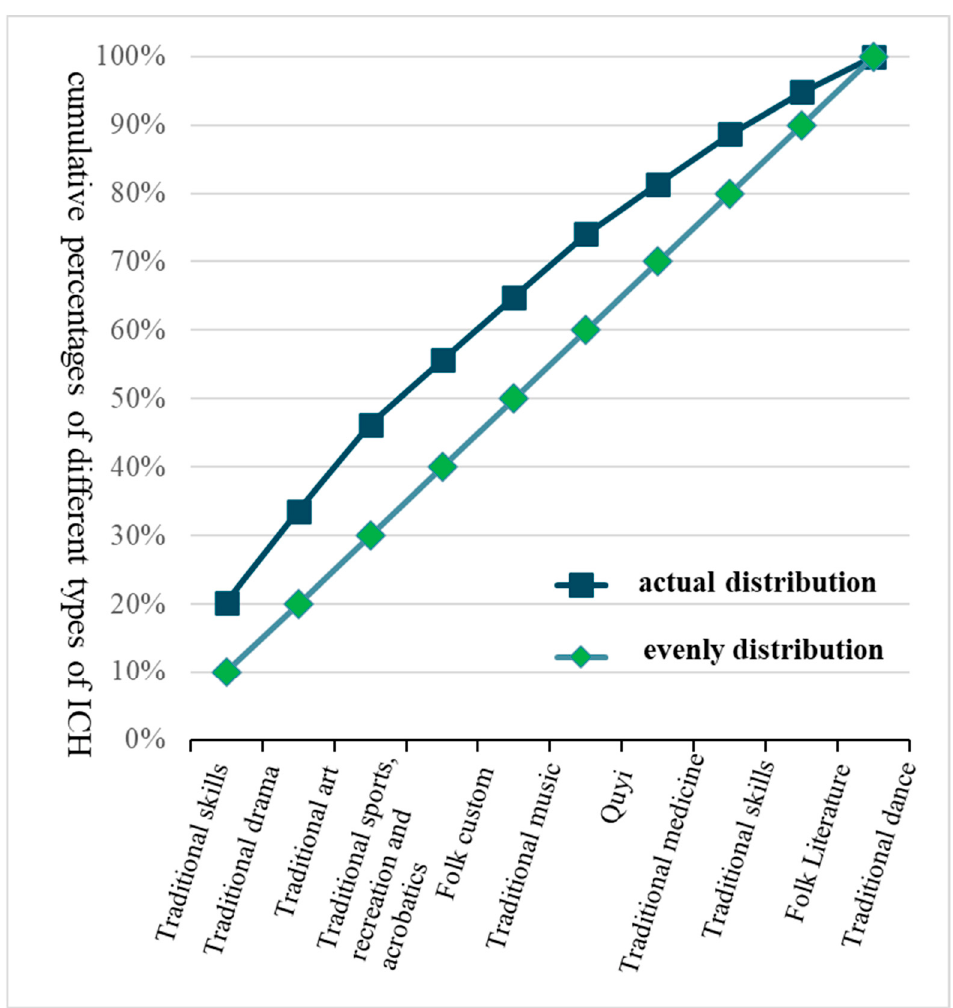
Figure 2. Lorenz curve distribution of intangible cultural heritage (ICH).